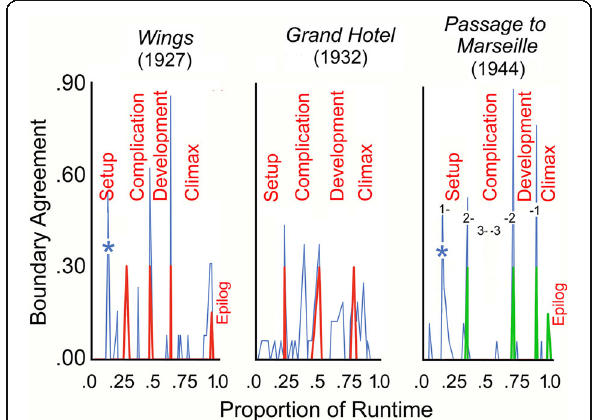
Fig. 1 The correspondence between the aggregated viewer responses (proportional agreement that a narrative boundary has occurred) and theoretical considerations in segmenting three early films. The thin blue spikes are the viewers ’ data; the thicker red spikes in the left and middle panels derive from Thompson (1999), and the thicker green spikes derive from descriptions by her and by Bordwell (2006). The width of the base of the spikes is due to two factors. The left flank represents the duration of the last scene before the transition, and the right flank the duration of the scene following it. The right panel also has a series of numbers that represent the beginnings and ends of the nested